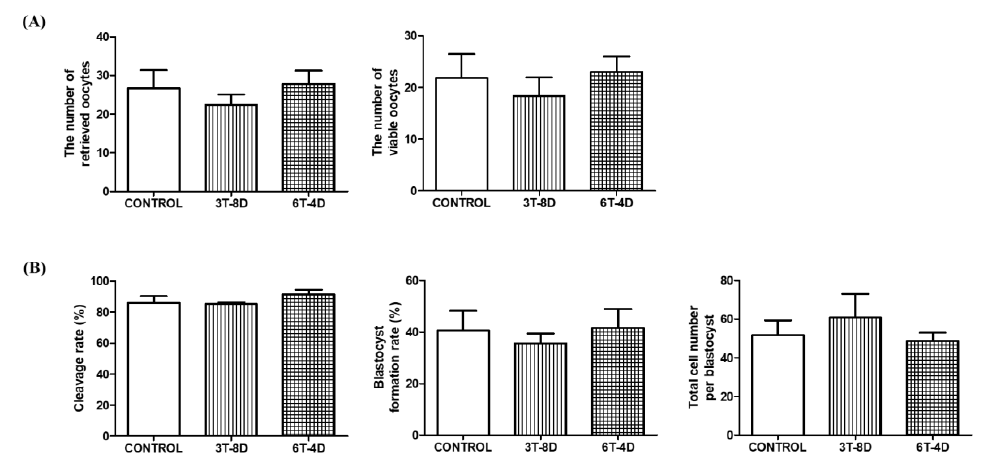
Figure 3. Evaluation of ( A ) ovulation status and ( B ) embryo development competence after parthenogenetic activation from the control and groups of human adipose-derived stem cell conditioned medium ASC-CM intravenous injection in 6-month-old mice. Data are expressed as the mean ± standard error of the mean (SEM). 4D-6T, six times injection in four day intervals; 8D-3T, three times injection in eight day intervals.